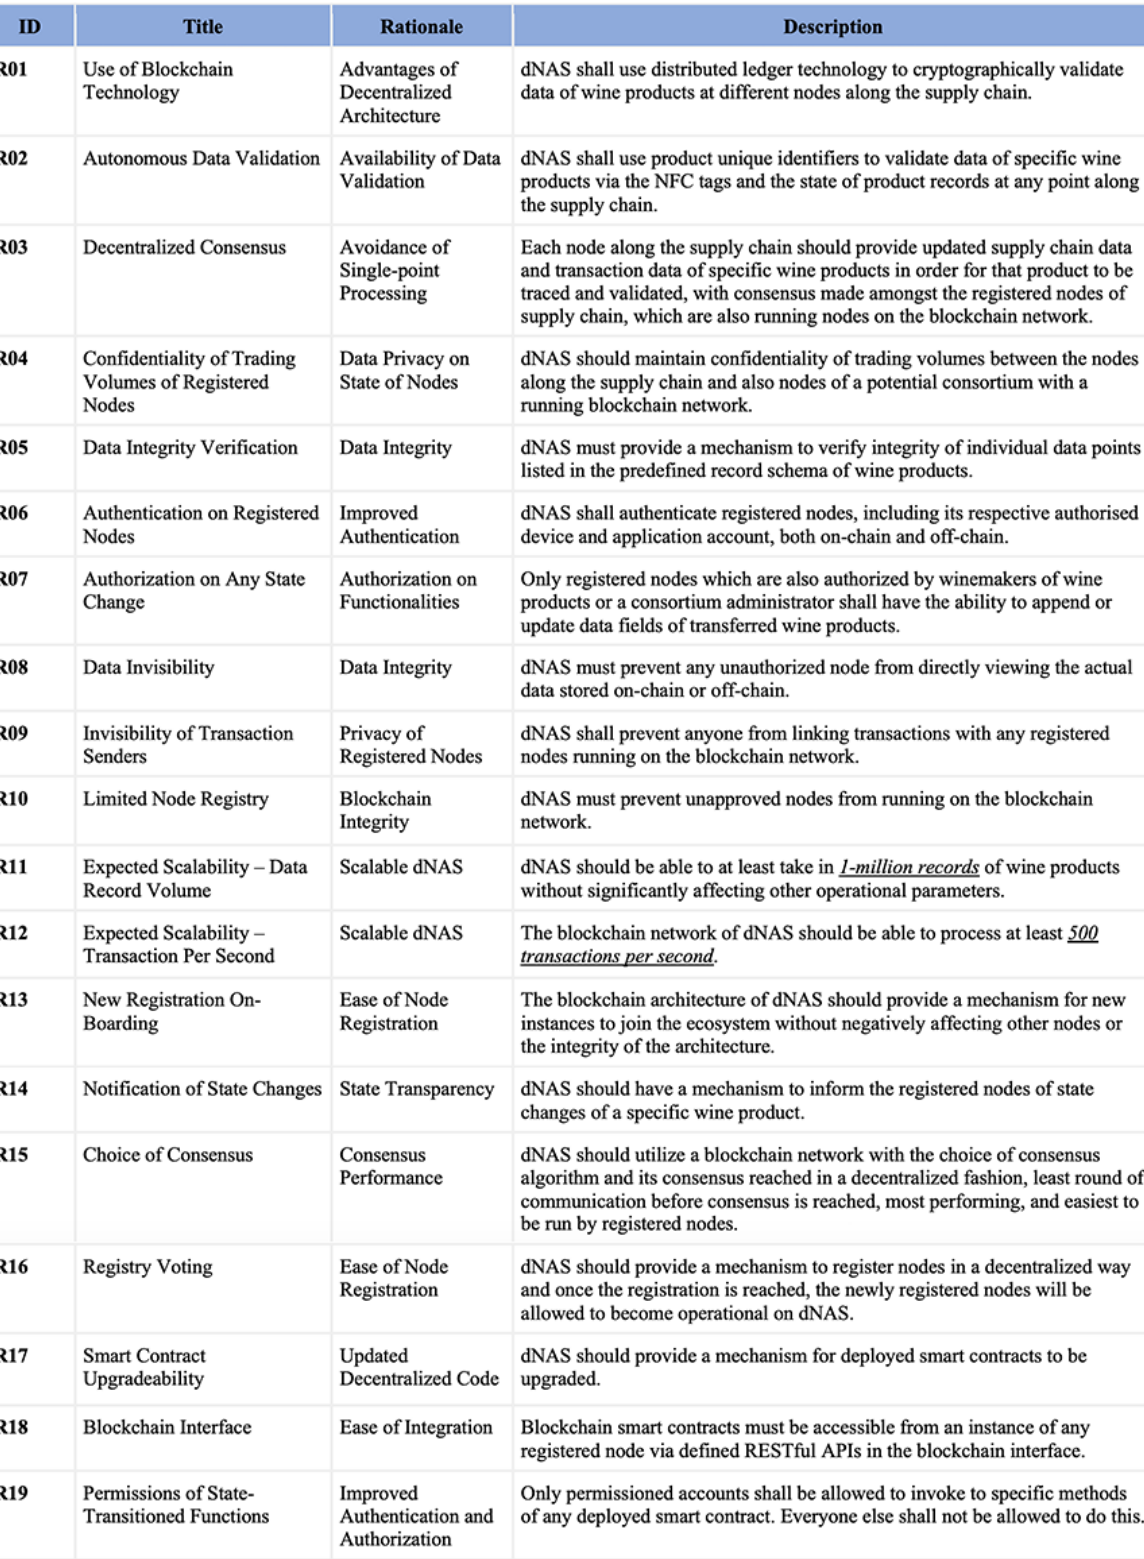
Figure A5. System requirements of proposed